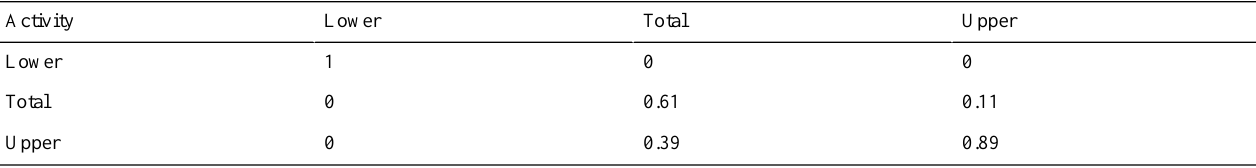
Table 8. Normalized confusion matrix showing percentage of correctly classified instances for the random forest model used for activity type classification tasks based on major body movement location. Each column shows the actual activity and rows represent the predicted labels.